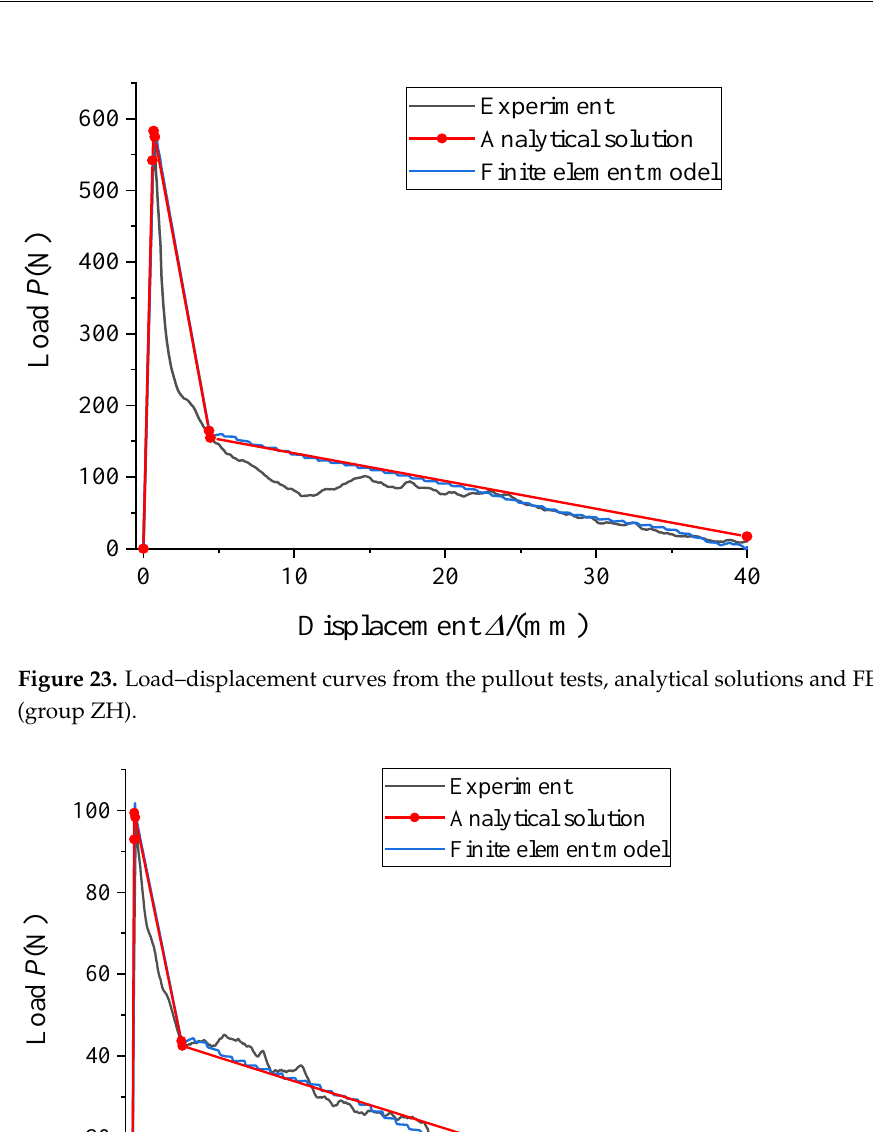
Figure 22. Load–displacement curves from the pullout tests, analytical solutions and FE simulations (group ZZ): ( a ) ZZ1: Z6011 + Zr(NO 3 ) 4 ; ( b ) ZZ2: Z6020 + Zr(NO 3 ) 4 ; ( c ) ZZ3: Z6030 + Zr(NO 3 ) 4 ; ( d ) ZZ4: Z6040 + Zr(NO 3 ) 4 .